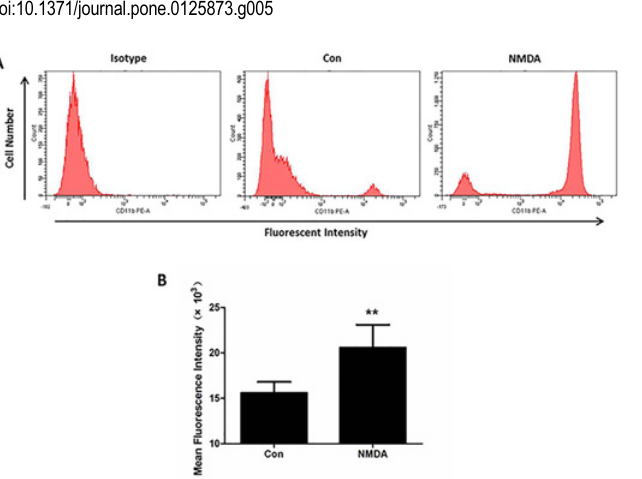
Fig 5. Effect of memantine on bleomycin-induced increases in the tissue malondialdehyde (MDA) levels. The lung tissues were collected on Day 7. n = 3 – 6. Bars: mean ± SD. ** P < 0.01 vs Con group; ## P < 0.01 vs BLM group. The experiment was repeated three times in the same condition.